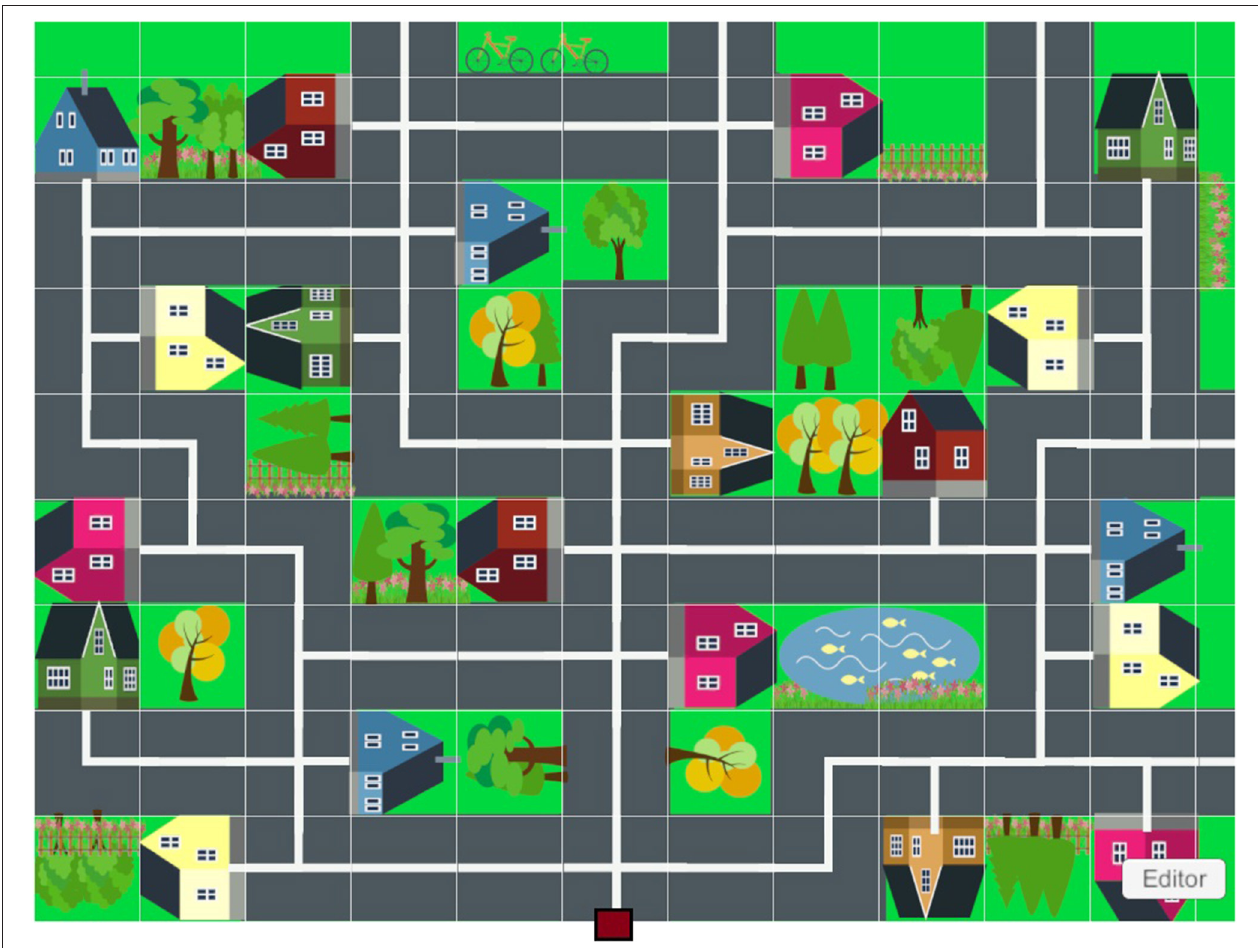
FIGURE 1 | VC TM projection on the ground. The red square indicates the starting